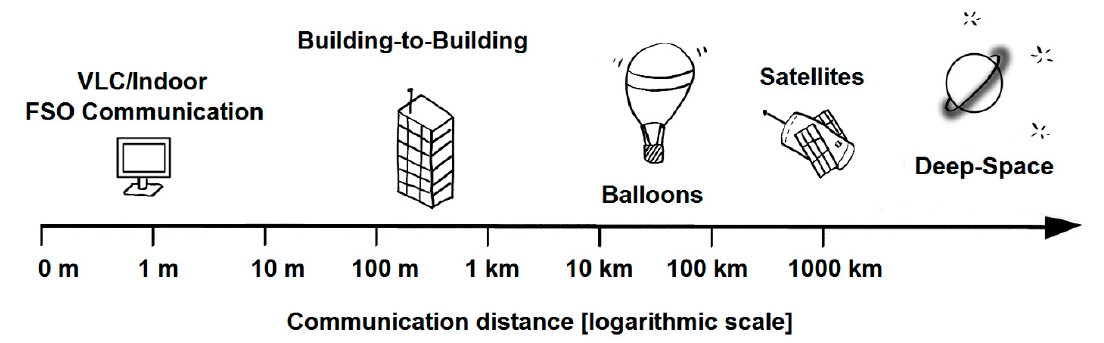
Figure 7. Classification of FSO systems based on their coverage.